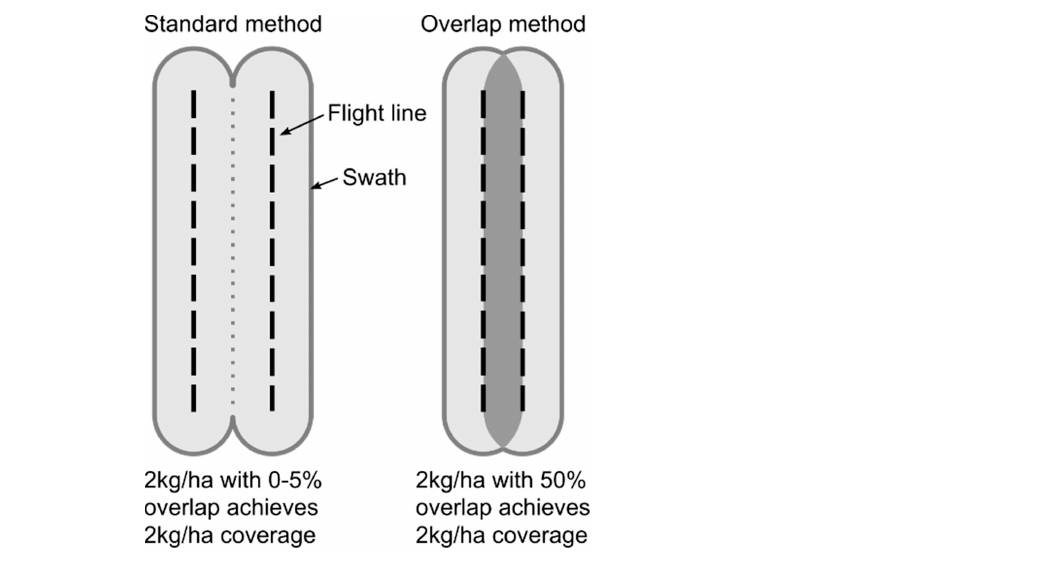
Figure 2. Helicopter flight paths for the 1080 bait applications. Standard 0% overlap flight path ( left ) versus 1080-to-zero 50% overlap ( right